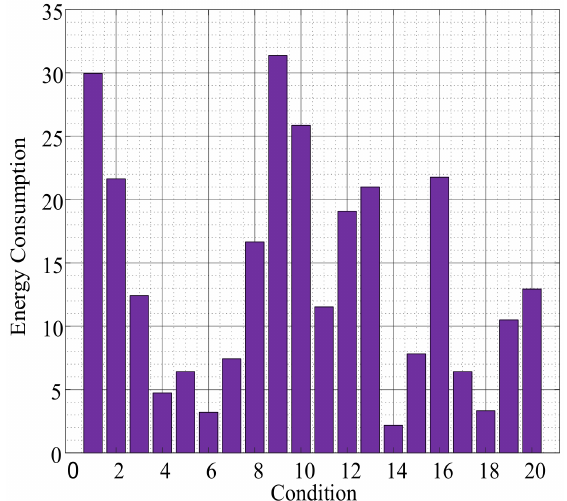
Figure 18. Energy for seventh line condition.